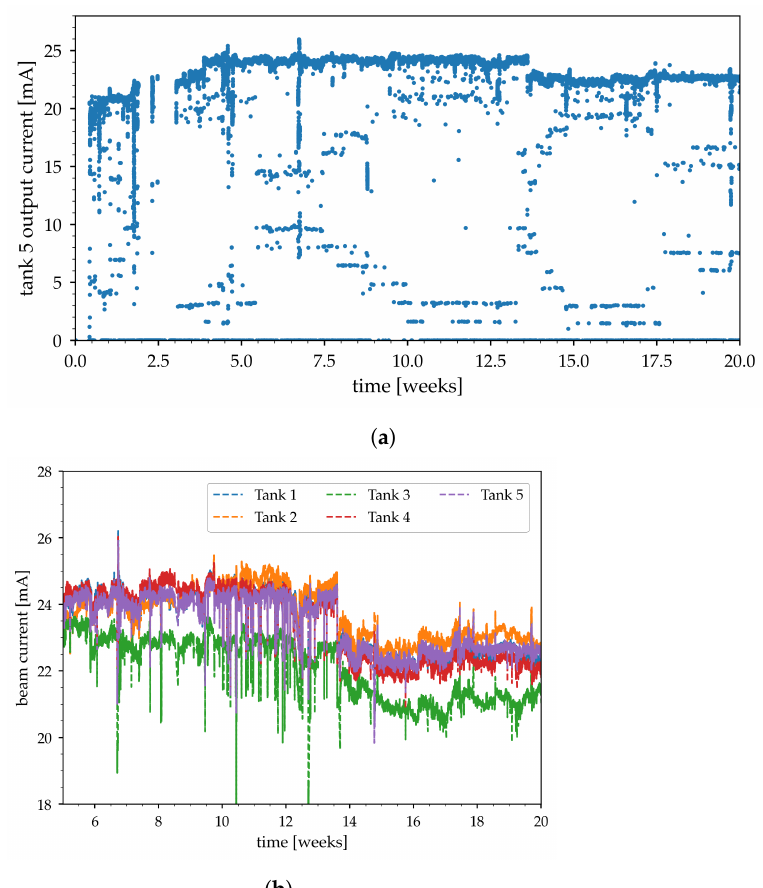
Figure 7. ( a ) shows the current measurements from the low energy linac during the whole operational period. ( b ) shows the current measurements from the low energy linac during the 15 week period of interest focusing on the nominal beam current